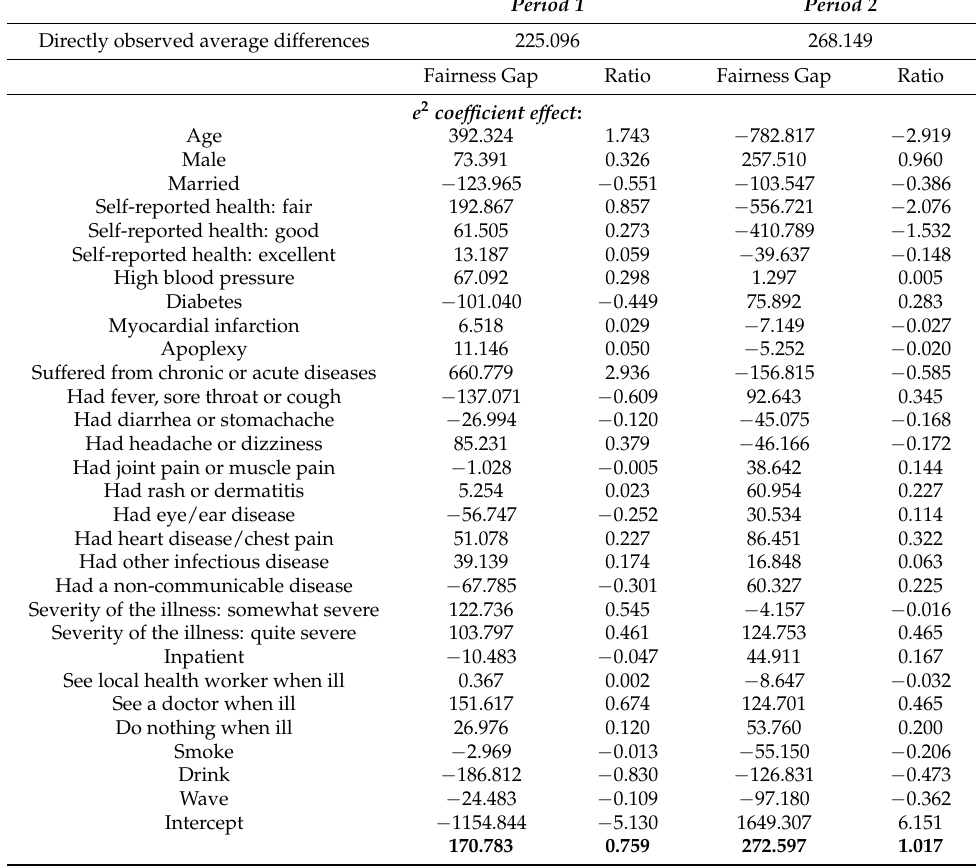
Table 3. Robustness Test of Table 2; Rural as the Reference